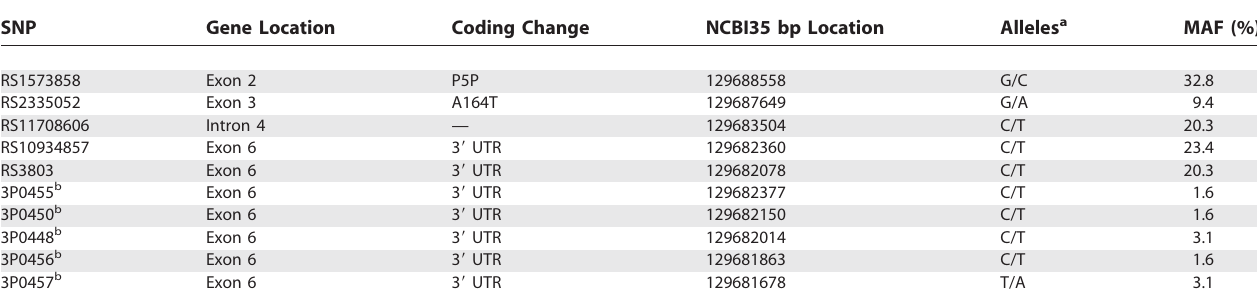
Table 1. SNPs Identified by Sequencing the Six Exons of GATA2 in 32 Individuals Including Five Novel GATA2 SNPs SNP